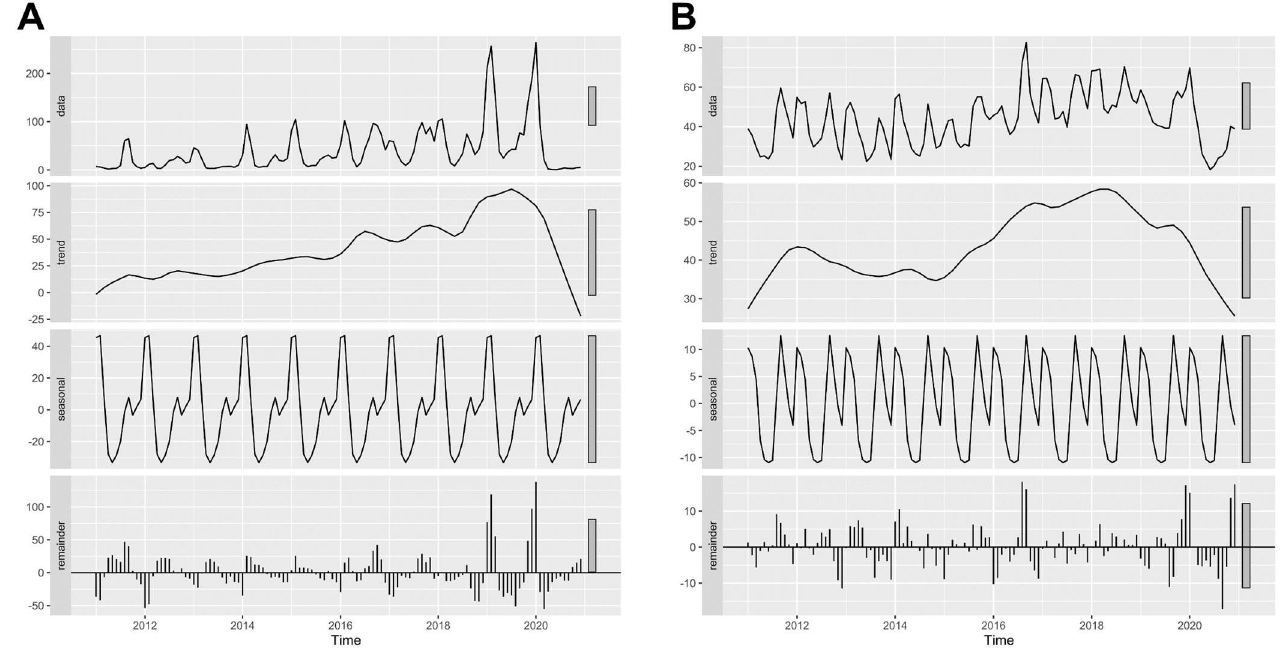
Figure 2. Seasonal-trend decomposition using loess (STL) plots of ( A ) influenza and ( B ) pneumonia in Chiang Mai from 2011 to 2020. A data column of the plot showed the original data of the monthly incidence rate, which were decomposed to trend, seasonal, and remainder plots.